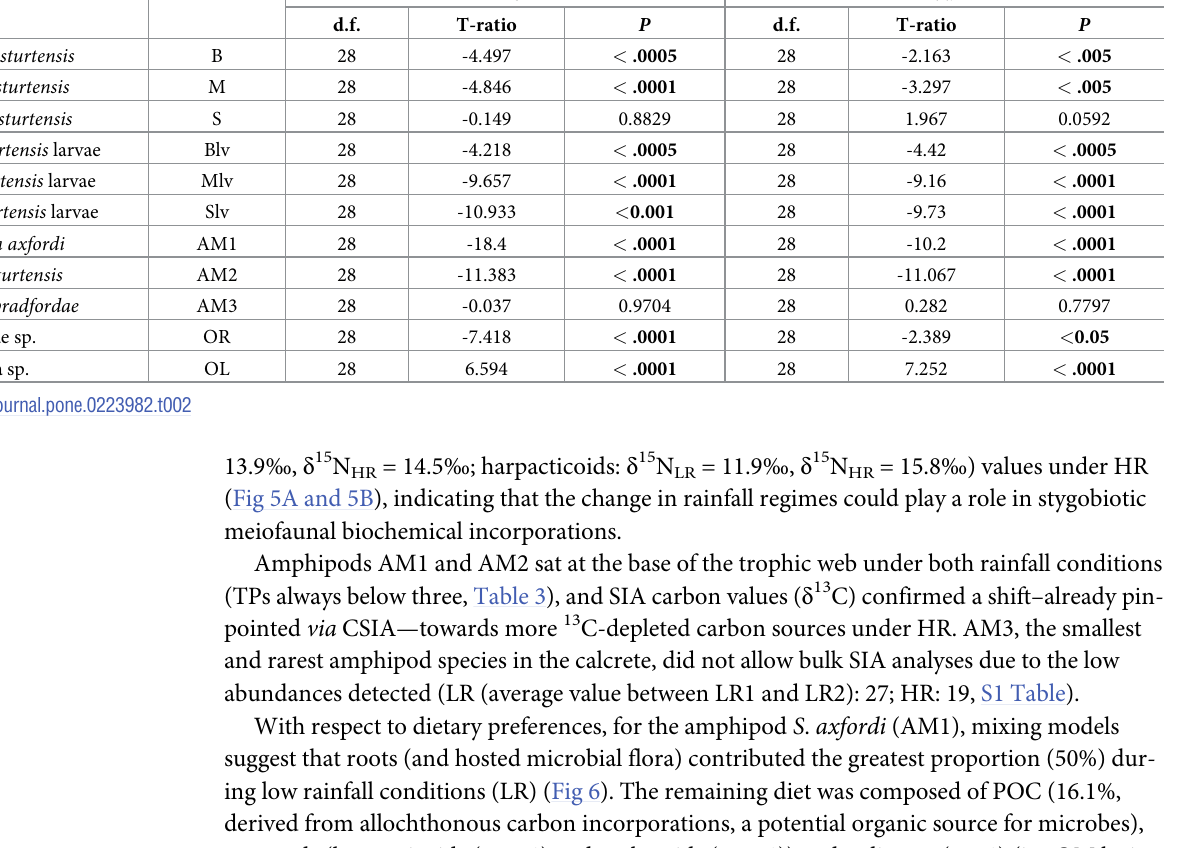
Table 2. Tuckey’s post hoc pairwise comparisons between phenylalanine and valine values under low (LR) and high (HR) rainfall conditions. In bold significant results. Taxon